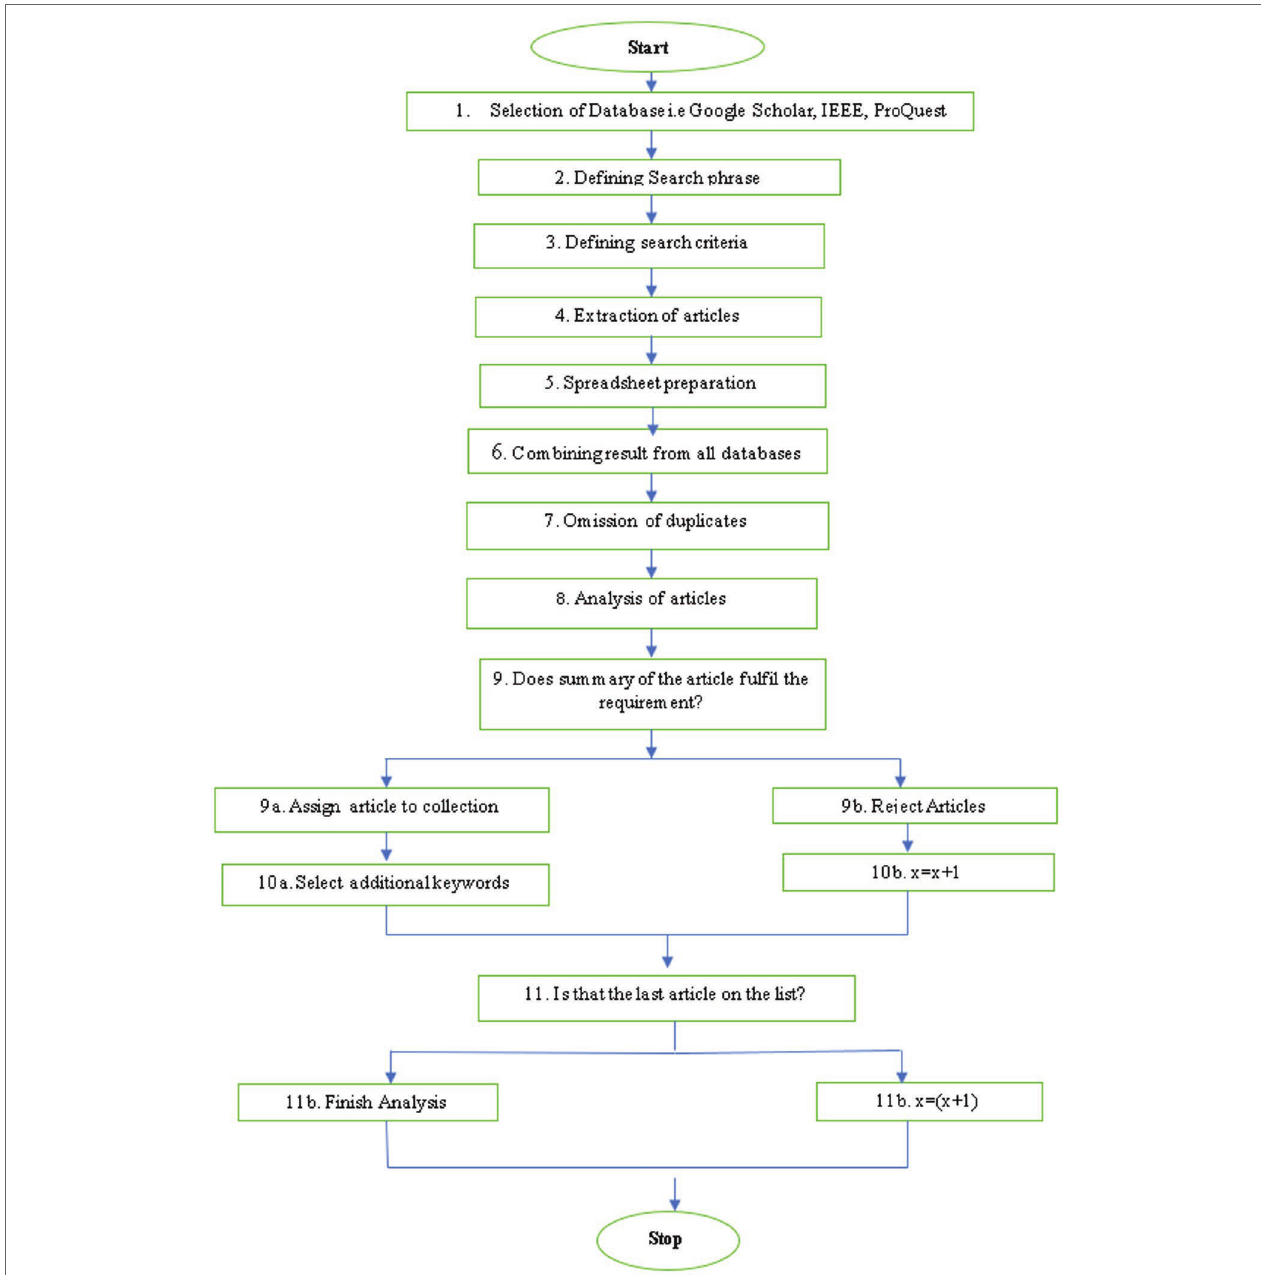
FIGURE 3 | Article selection